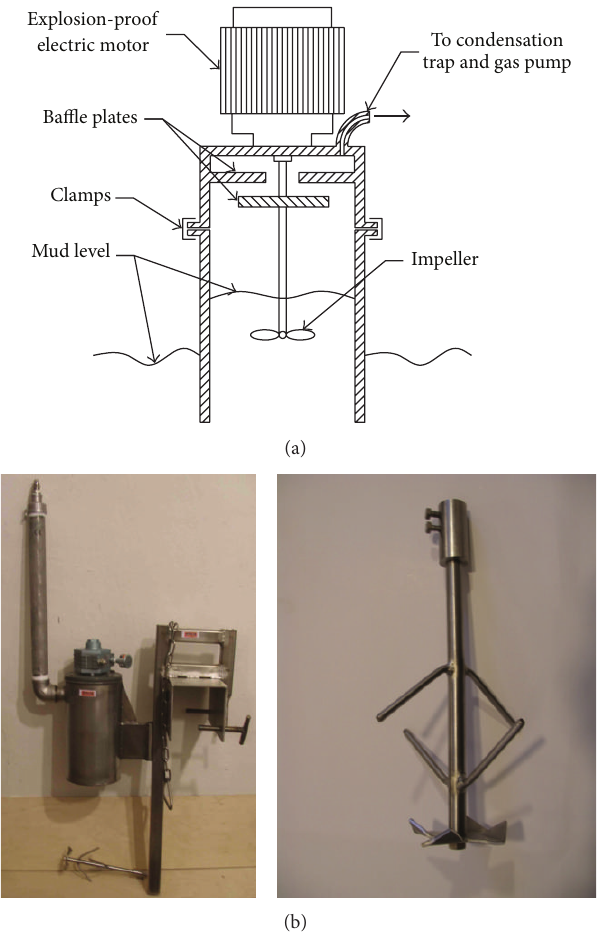
Figure 2: The classical desorber: (a) scheme of operations; (b) picture of the desorber (left) and the mixer